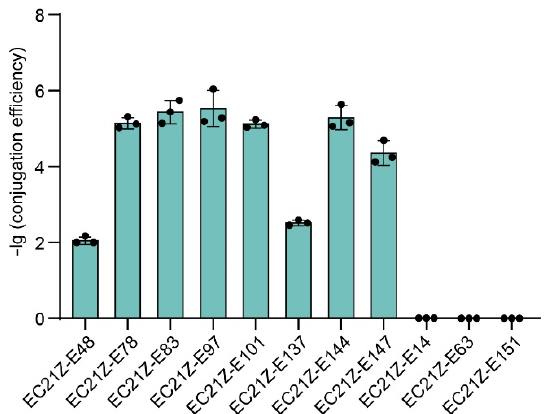
Figure 2. The conjugation transfer frequency of 11 bla NDM - or mcr- positive E. coli strains.